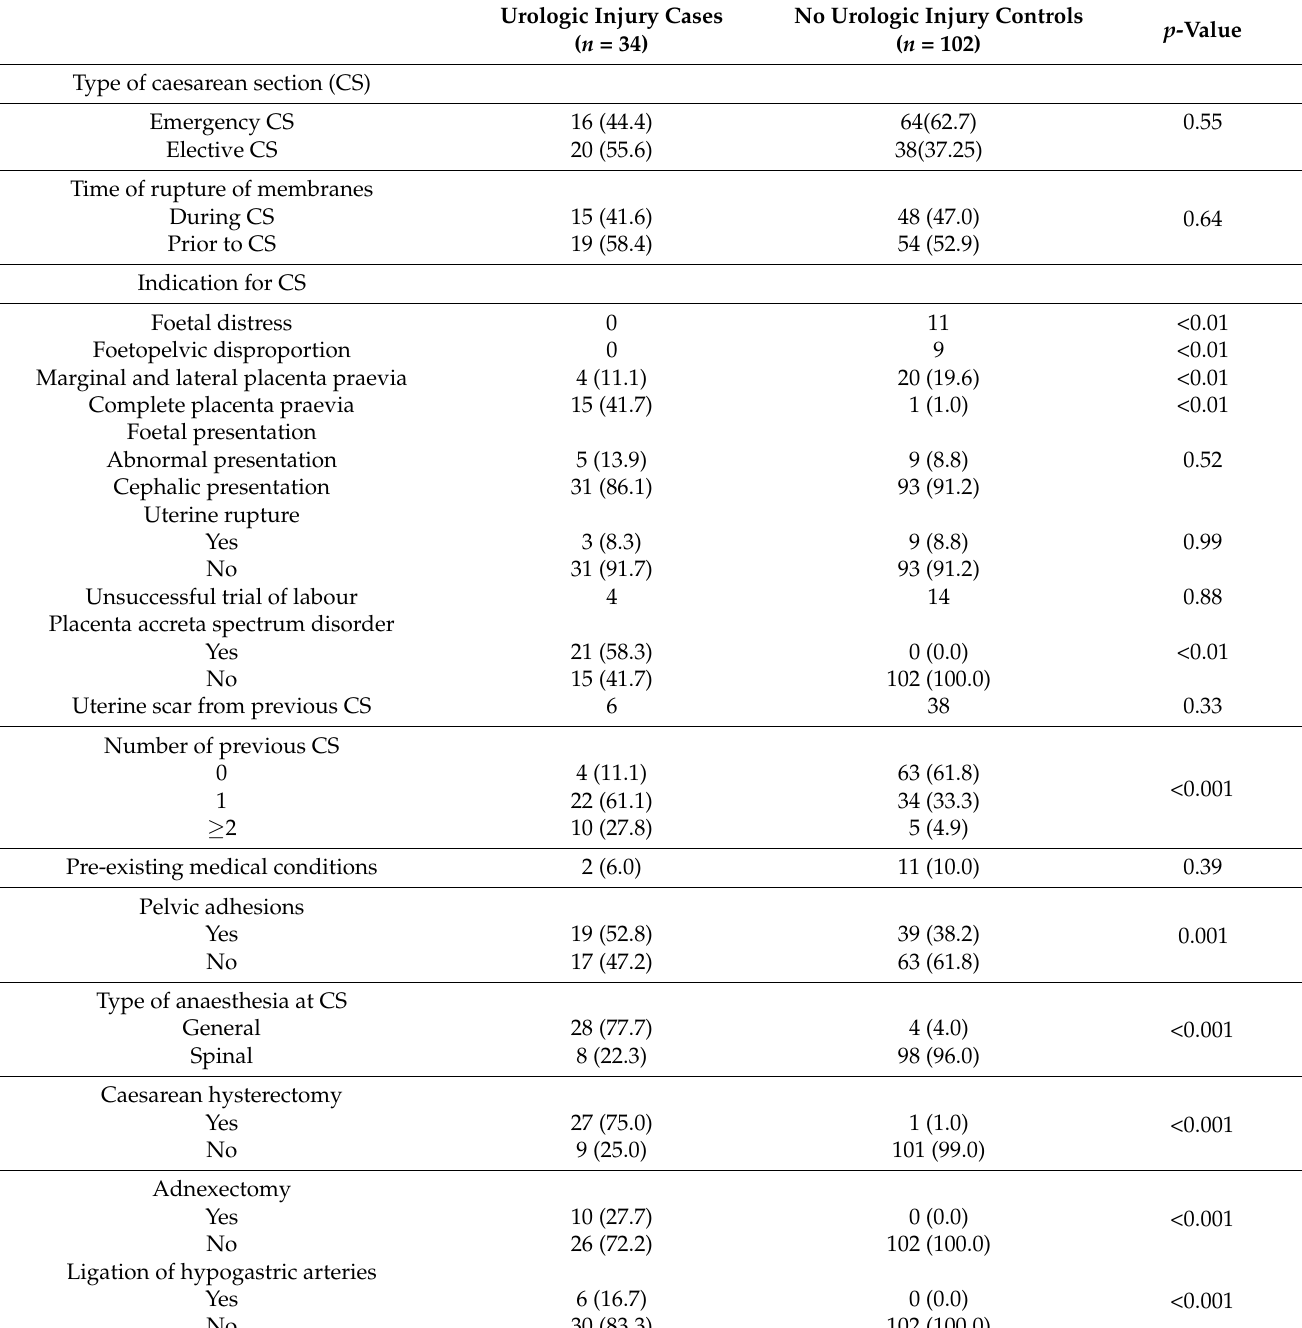
Table 2. Surgical characteristics of patients with urologic injury (cases) in comparison with patients with no urologic injuries